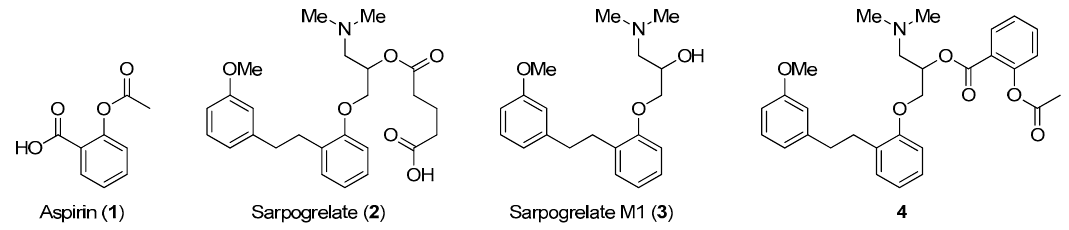
Figure 1. Structure of antiplatelet drugs and metabolites.